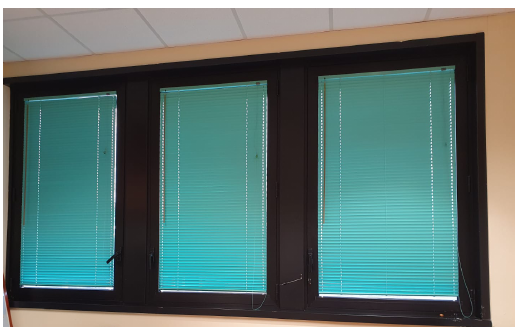
Figure 20. Windows shutters.